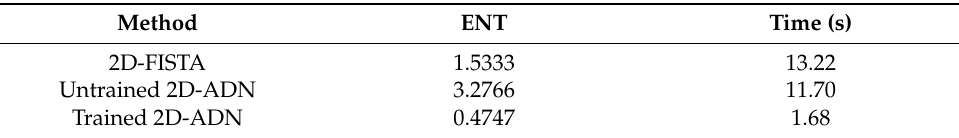
Figure 16. Yak ‐ 42 images of the 2D incomplete data obtained by ( a ) 2D ‐ FISTA, ( b ) untrained 2D ‐ ADN, and ( c ) trained 2D ‐ ADN. Table 9. Quantitative performance evaluation for the 2D incomplete measured data. Table 8. Quantitative performance evaluation for the 2D incomplete measured data.